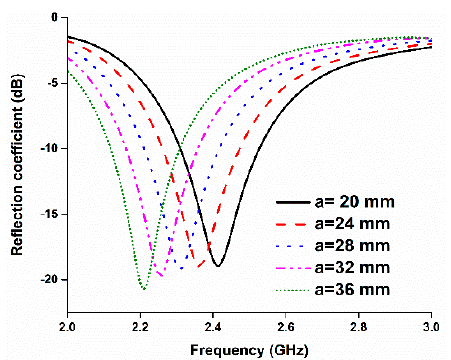
Figure 4. Variation in the reflection coefficient by changing the length of ‘a’.